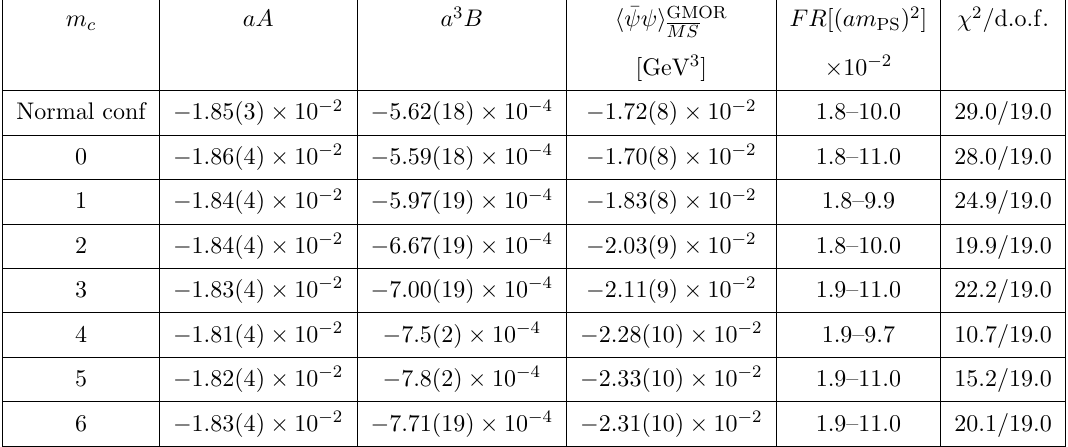
into MS -scheme at 2 MS